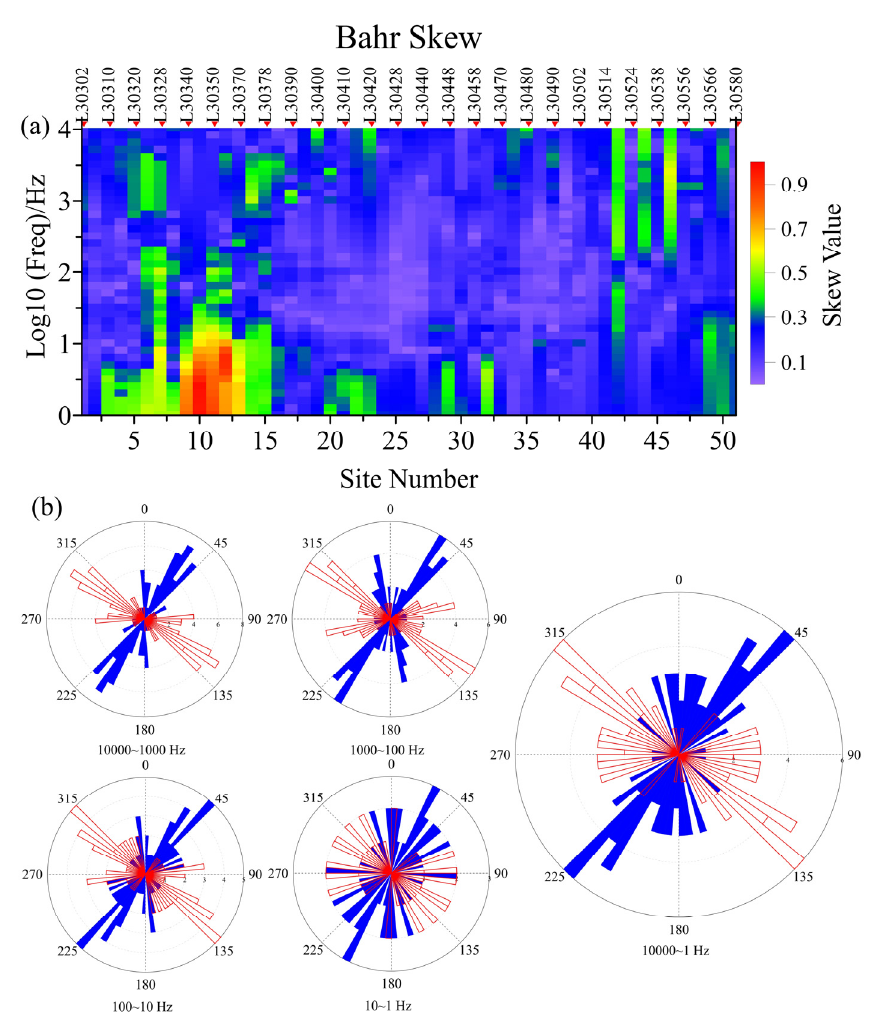
Figure 2. ( a ) Bahr skewness map, showing the deviation from 2D structure. ( b ) Rose diagrams drawn using multisite–multifrequency tensor decomposition method, which show the geoelectric strike direction at different frequency ranges.